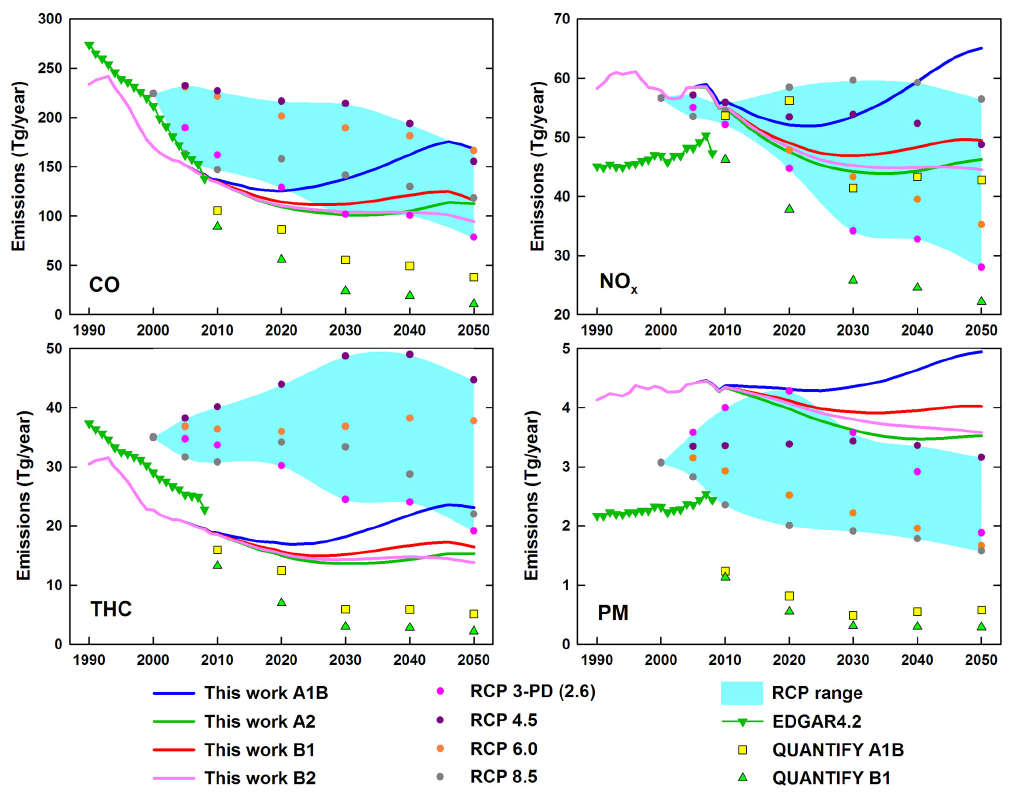
Figure 5. Comparison of global emission estimates for the whole transportation sector. The solid lines are total emissions estimated in this work under scenarios A1B, A2, B1, and B2, including on-road vehicles, non-road engines, total shipping (domestic and international), total aviation (domestic and international), and rail. The RCP scenarios (Moss et al., 2010) include emissions from surface transportation, aviation, and international shipping. EDGAR (JRC/PBL, 2011) includes emissions from road transport, inland navigation, international shipping, domestic and international aviation, and rail. QUANTIFY (DLR, 2009) includes emissions from road, maritime shipping, inland navigation, aviation, and rail. For PM, this work shows emissions of total PM, EDGAR shows emissions of PM 10 , QUANTIFY and RCP show the sum of the emissions of BC and